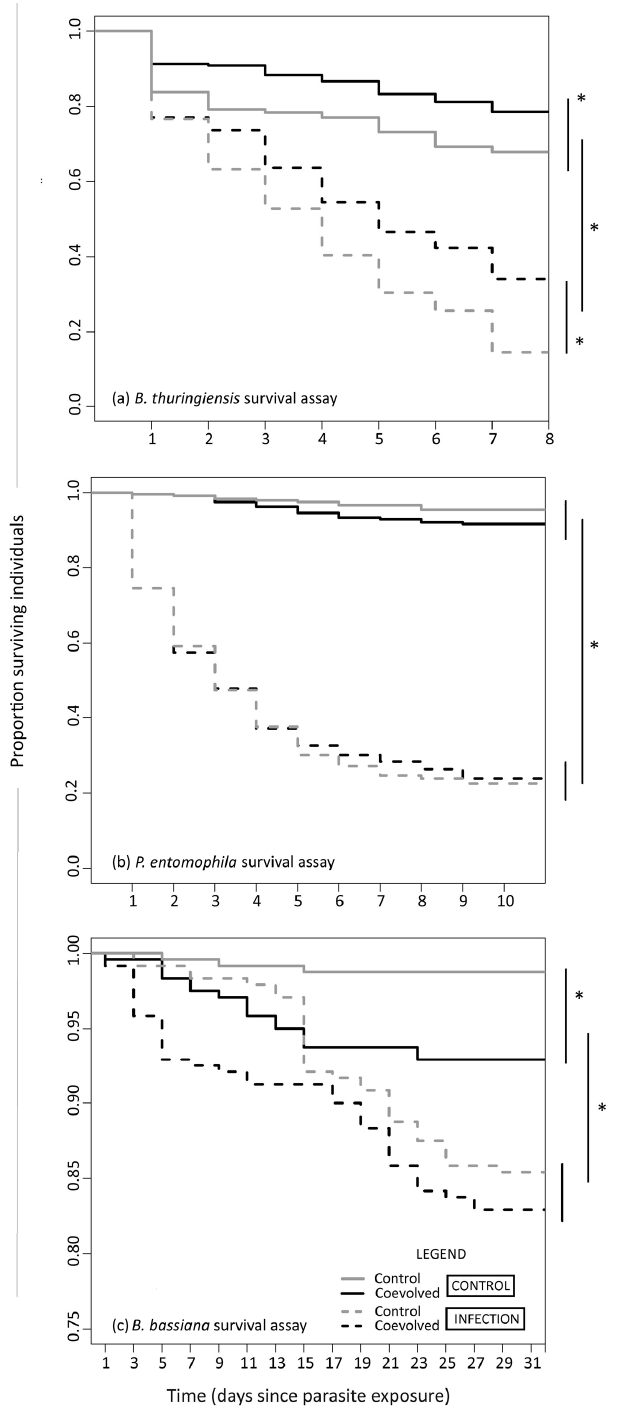
Figure 1. Survival of B. bassiana coevolved beetles upon infection upon exposure to non-evolved ( a ) B. thuringiensis , ( b ) P. entomophila, and ( c ) B. bassiana. * denotes significance between groups. Note: y-axis in ( a ) starts from 0.75 for better visualization of data.